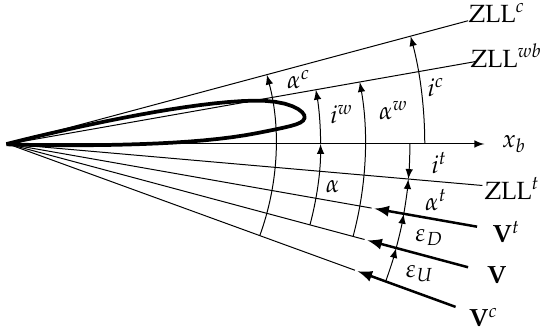
Figure 2. Definition of aerodynamic angles for all surfaces. ZLL stands for ’Zero-Lift